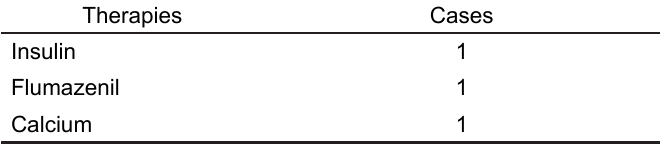
Table 2. Continued. Substances reported in death cases. Table 3. Continued. Therapies used in death